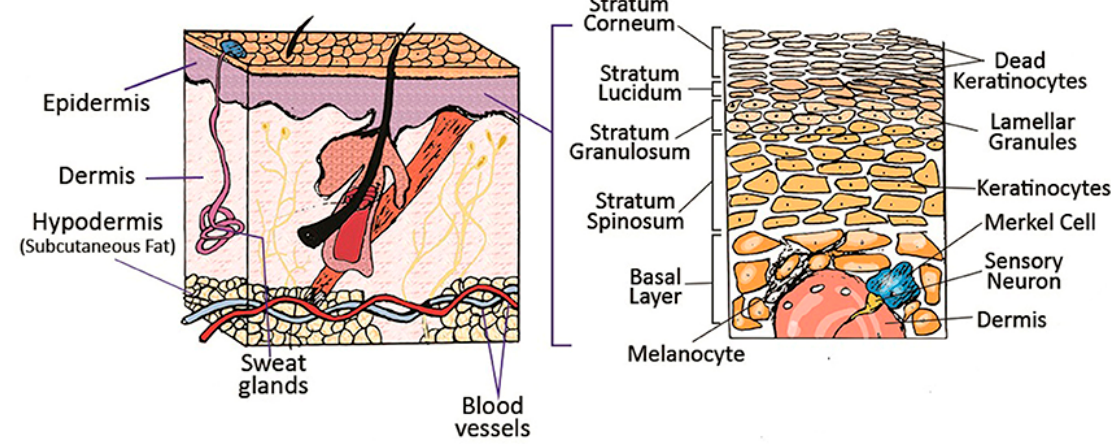
Figure 2 . Illustration of the skin structure comprising of different layers and appendages. Figure 2. Illustration of the skin structure comprising of di ff erent layers and appendages. Reproduced Reproduced with permission from [22]. Copyright © 2016 John Wiley and Sons. with permission from [22]. Copyright © 2016 John Wiley and